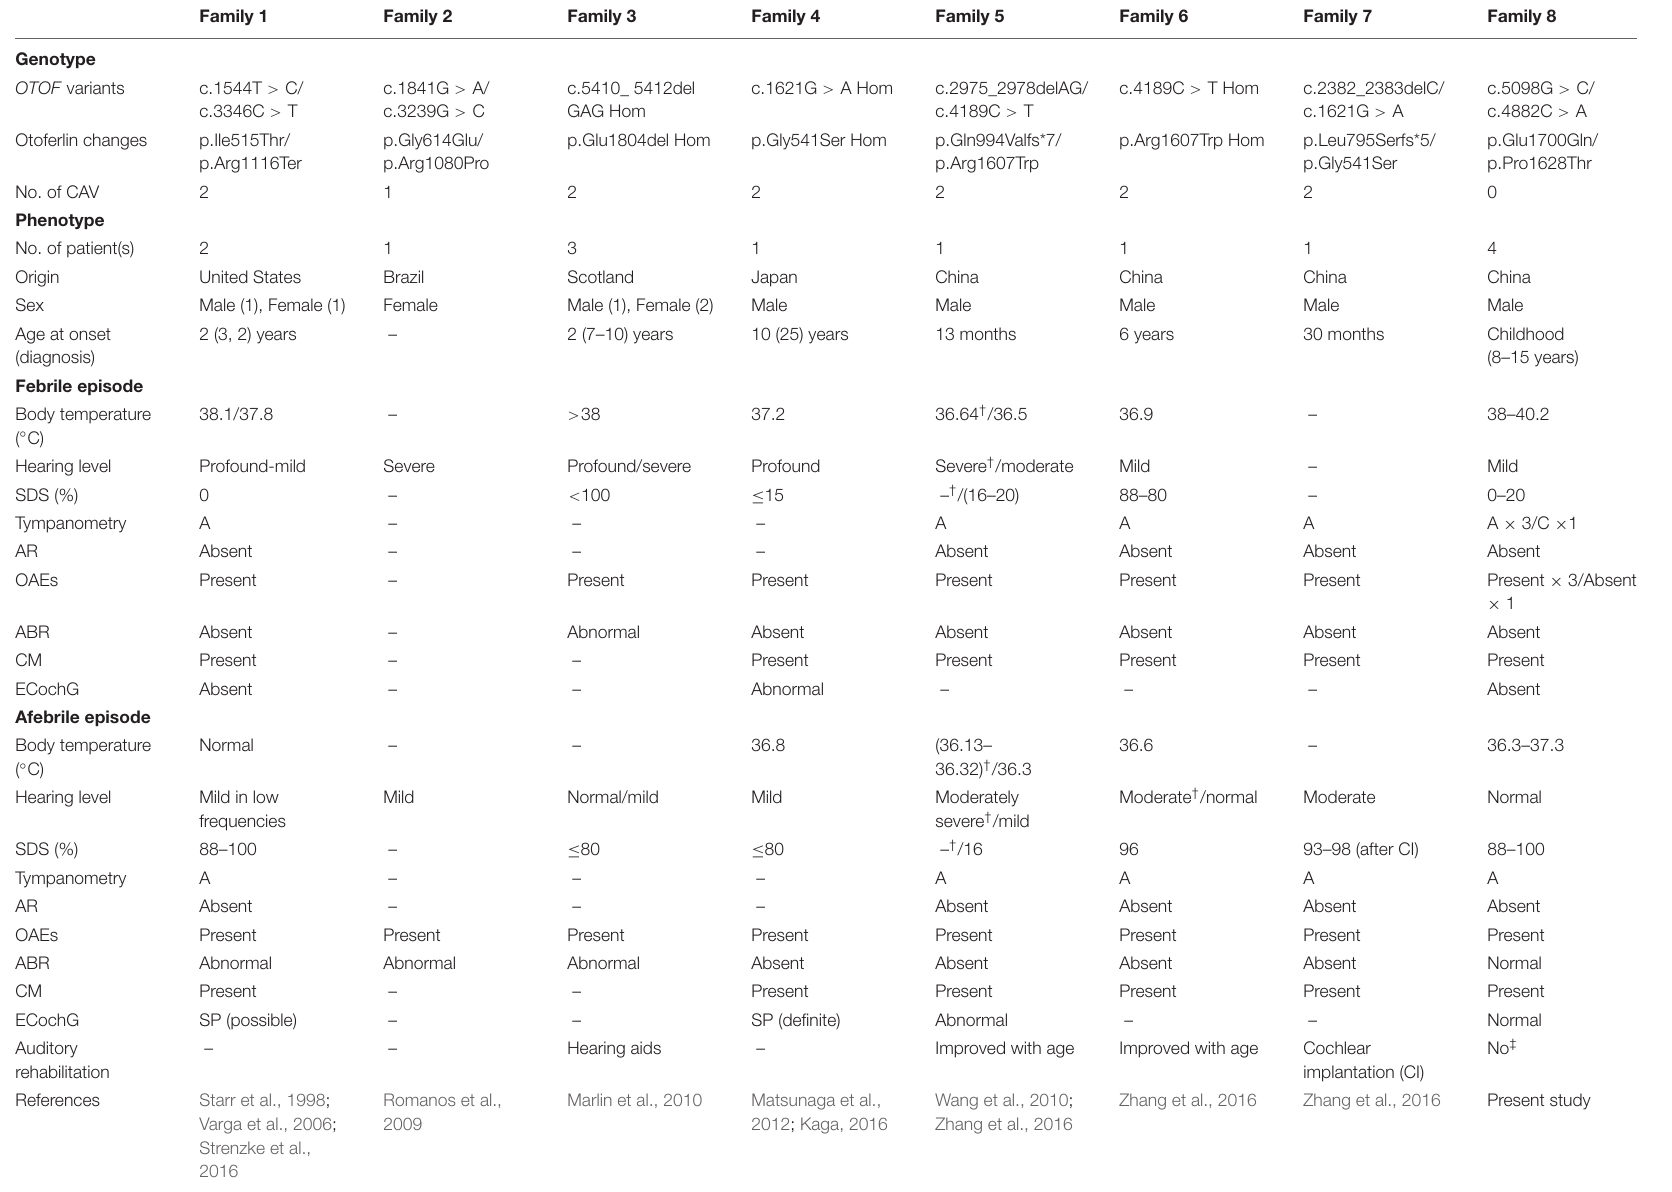
TABLE 1 | Overview of genotype–phenotype correlations of OTOF variants in the TSAN patients identified in the present study or previous